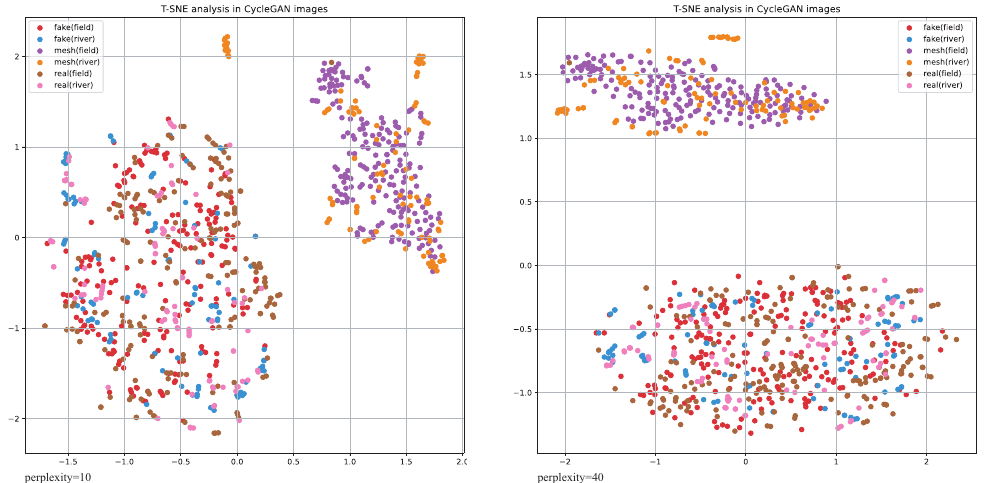
Figure 7. t-SNE analysis for various types of IR images, including the images generated by CycleGAN